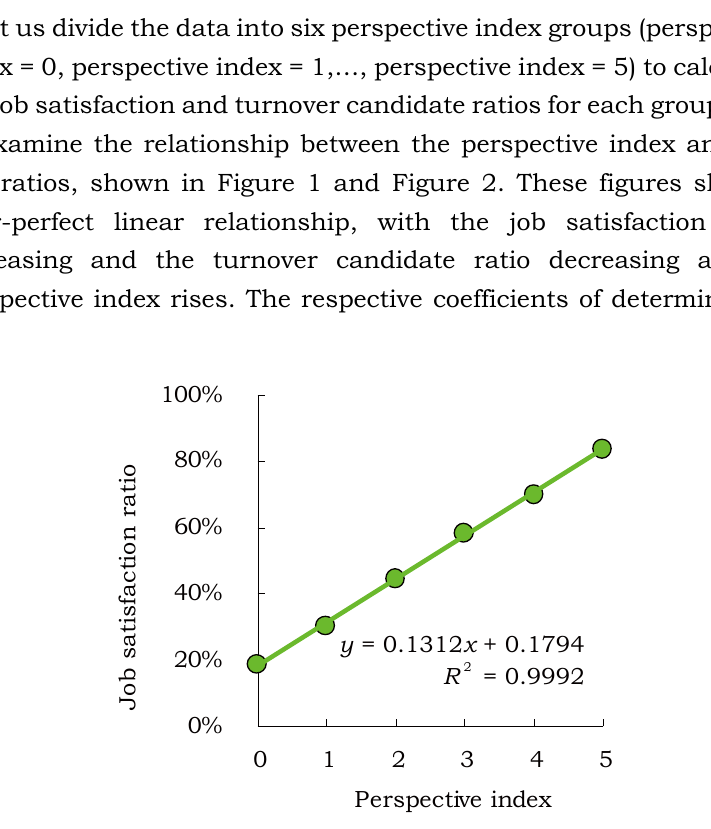
Figure 1. Perspective index and job satisfaction ratio (JPC Survey, 1992–2000, N =